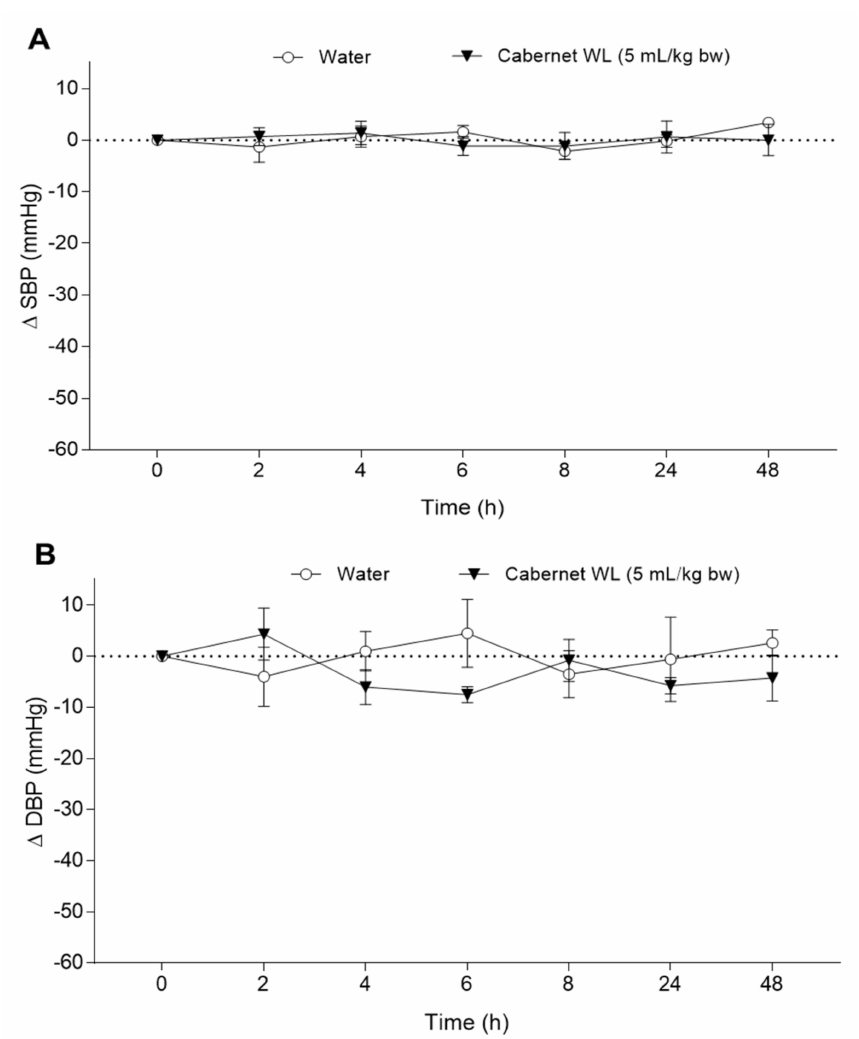
Figure 5. Decrease in systolic blood pressure (SBP, A ) and diastolic blood pressure (DBP, B ) caused in Wistar–Kyoto rats after the acute administration of water or Cabernet WL (5 mL/g bw). Data are expressed as mean ( n = 6) ± SEM. No significant differences ( p < 0.05) were found. p was estimated by two-way